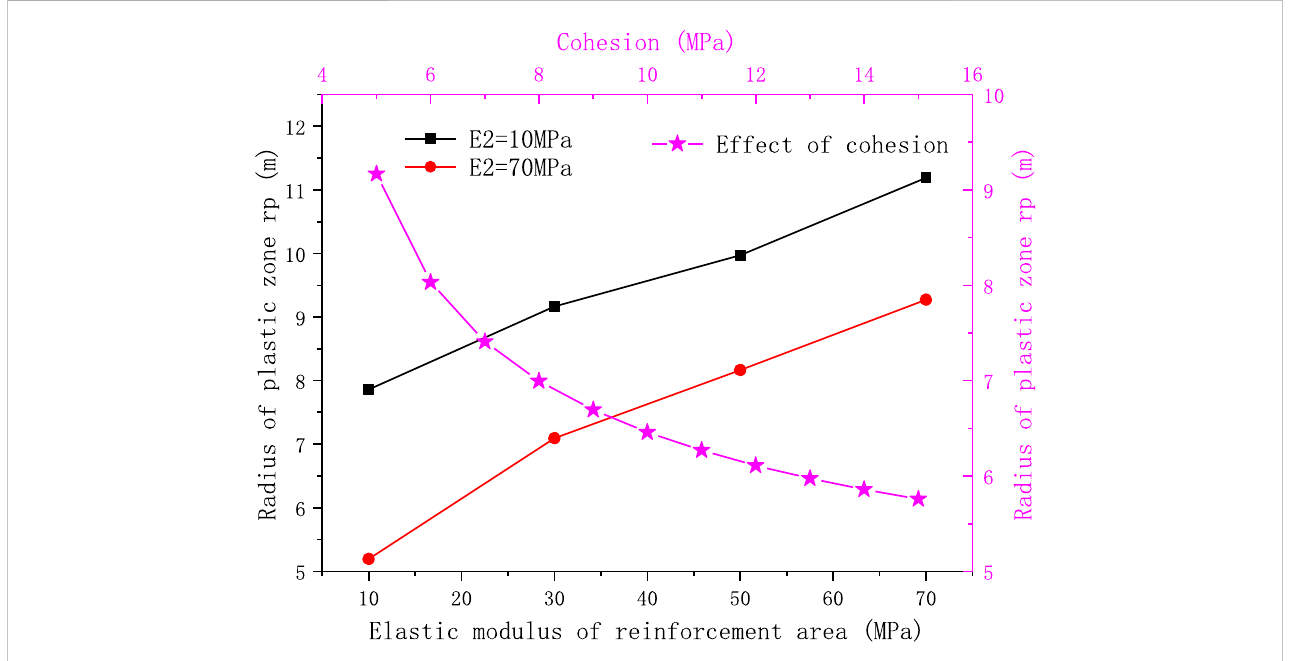
FIGURE 5 Effect of elastic modulus and cohesion on plastic zone radius.